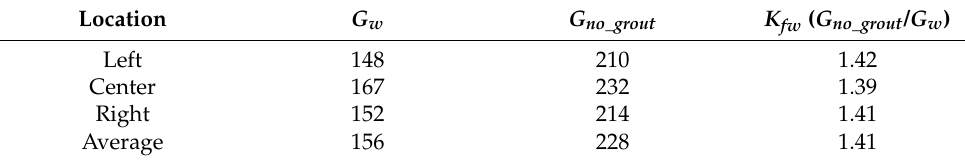
Figure 24. Gray value profiles of ( a ) Left; ( b ) Center; ( c ) Right in Figure 22. By identifying the sheath range within the gray value profile, gray values could be obtained. The evaluated values are summarized in Table 2. As predicted above, the average ratio of K is clearly higher than 1 and is approximately 1.4. Table 2. Gray values and K ratios for 200 mm PC, 950 keV and unfilled grout.